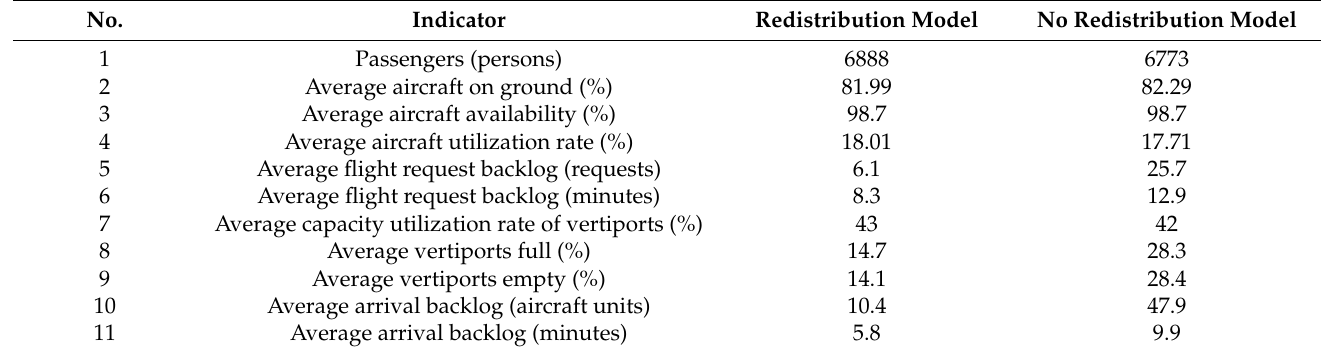
Table 3. Simulation results for redistribution factor in a high demand level